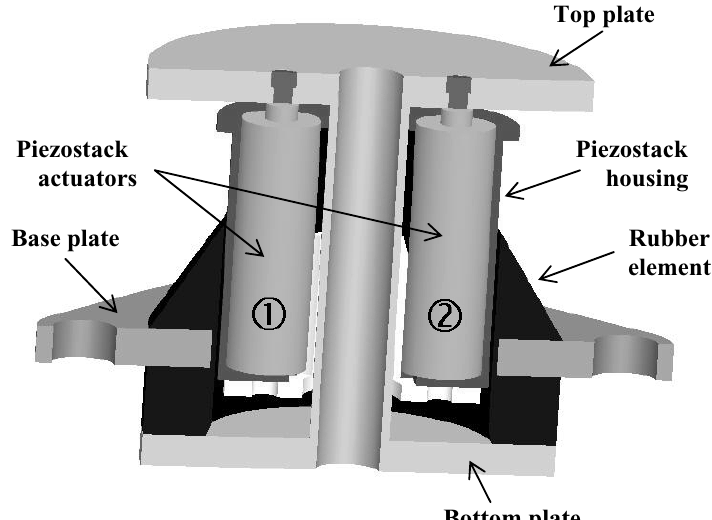
Fig. 3. Configuration of the proposed hybrid